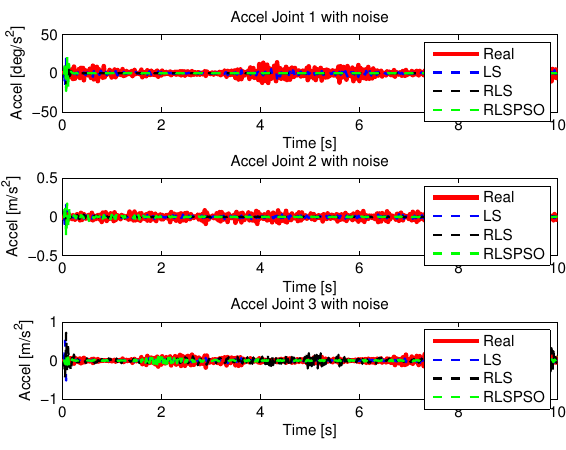
Figure 43. Speed with noise identifications.